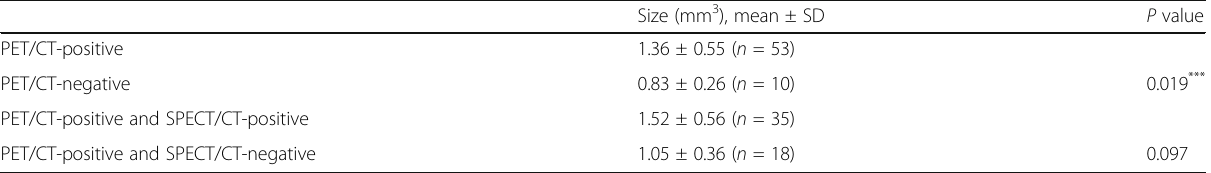
Table 3 Histopathological volume in hyper-functioning parathyroid glands from patients who tested positive/negative in PET/CT and